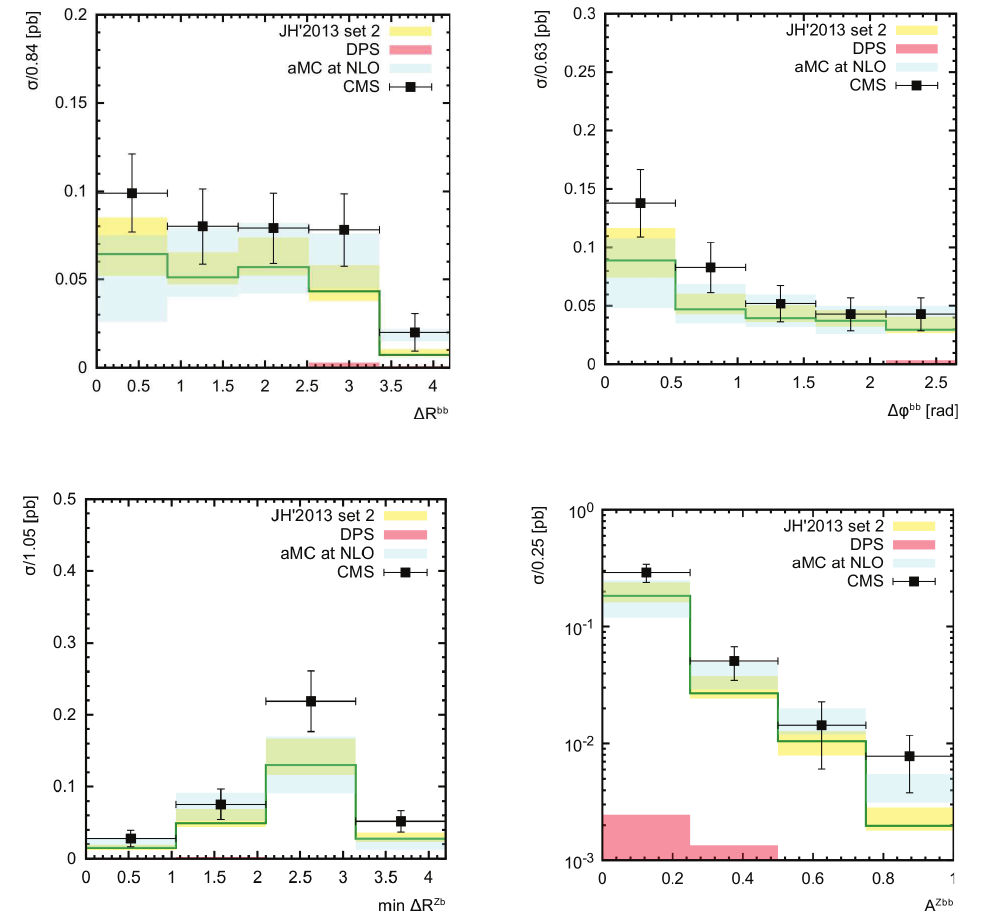
Figure 5. Associated production of a Z boson and two b -hadrons at √ s = 7 TeV under additional kinematical > 50 GeV. Notation of the histograms is the same as in Fig. 1. The cut on the Z boson transverse momentum p Z T data are from CMS [2]. The aMC@NLO [29] predictions are taken from